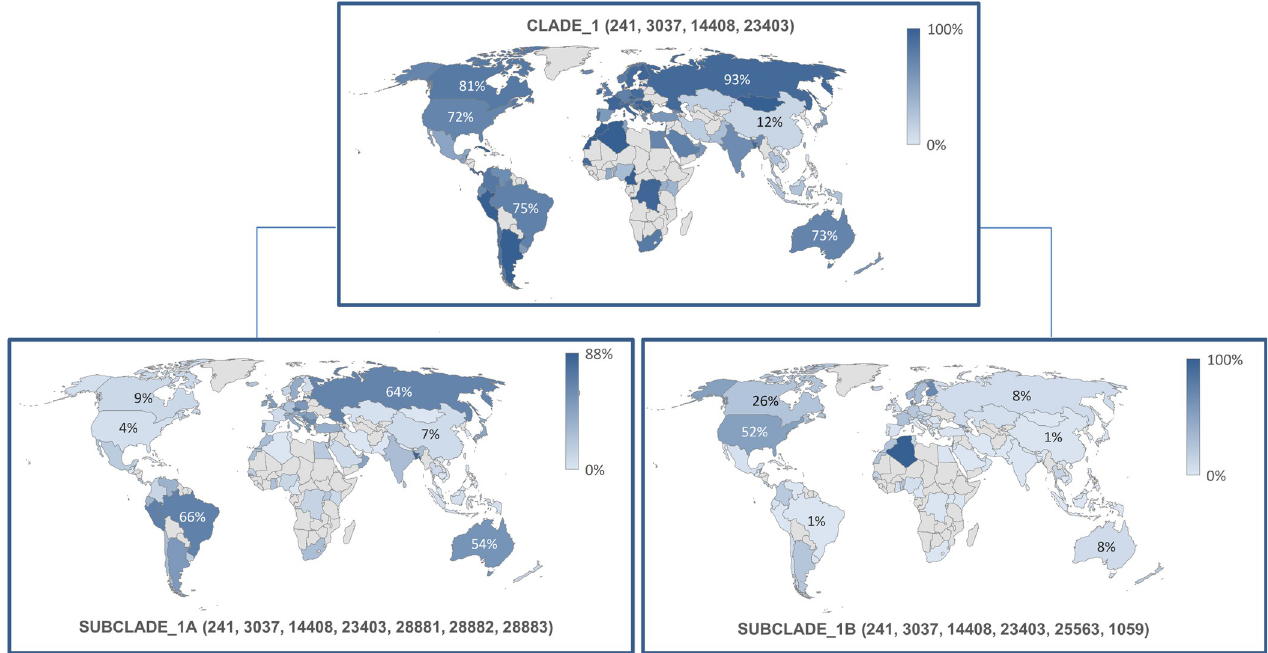
Fig 2. Frequency and geographical distribution of sub-clades 1A and